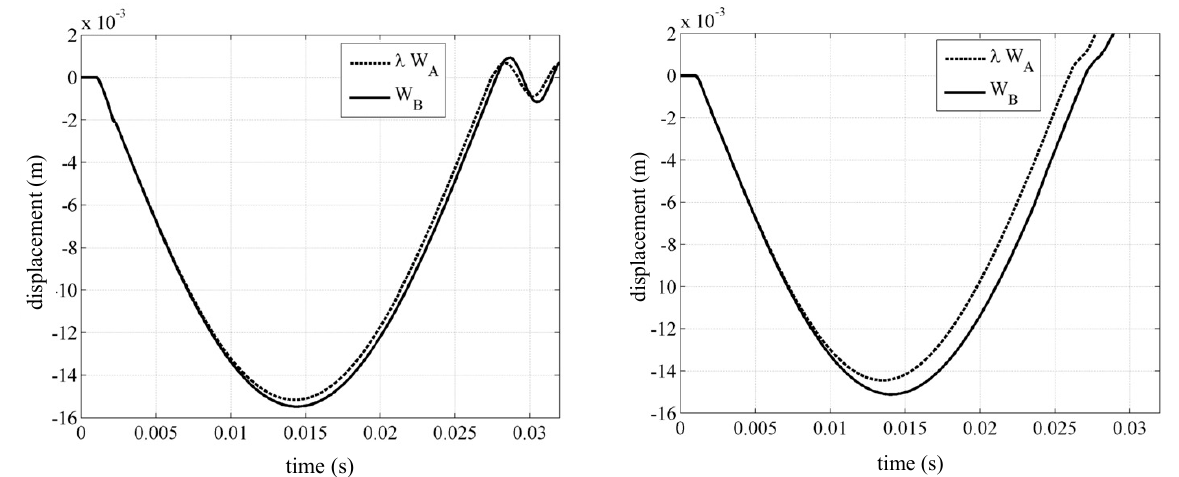
Figure 6. Time-history of the displacement of the central node as a function of time.